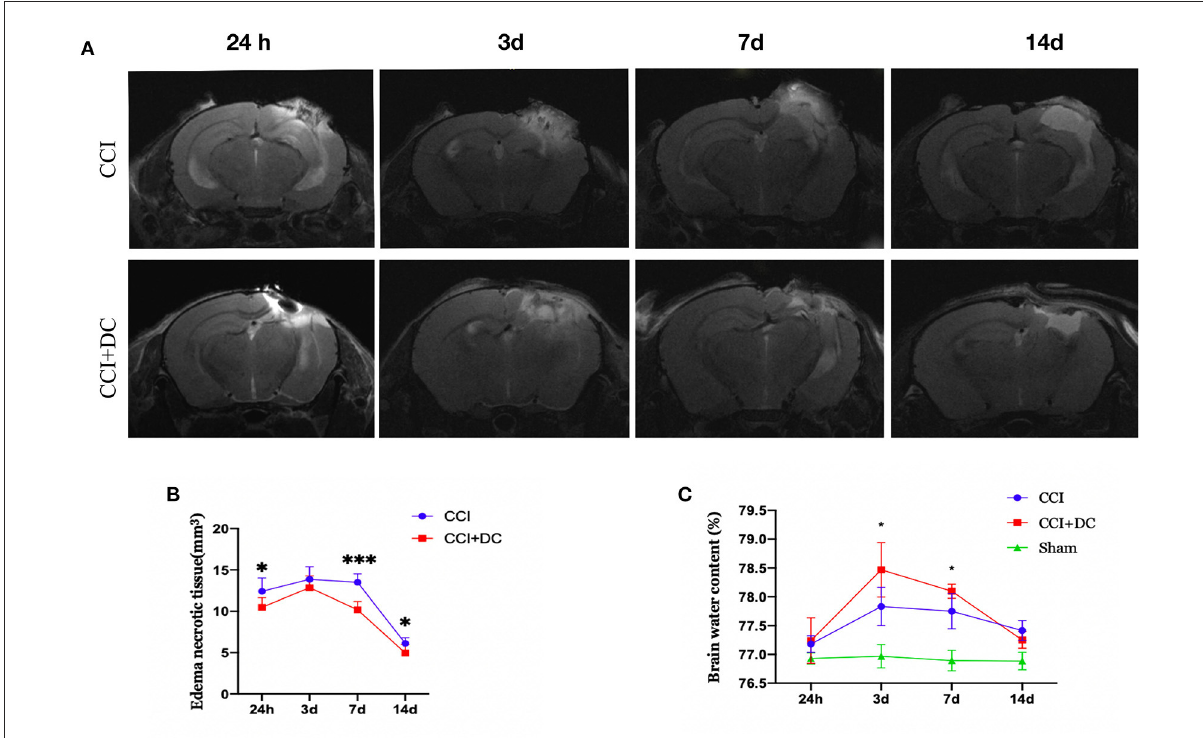
FIGURE6 Effect on cerebral edema. (A) MR examination was performed at different time points after CCI. (B) The statistical results were shown intracranial edema and contusion tissues of mice in the CCI + DC group at each time point after CCI was lower than that of the CCI group, and the difference was statistically significant on the first, 7th and 14th day after CCI. (C) Brain water content was detected by extracting brain tissue, as shown in the (C) on the 3rd and 7th day after CCI, the degree of brain edema in the CCI + DC group was significantly worse than that in the CCI group, and the difference was statistically significant ( n = 6/group, * P < 0.05, *** P < 0.001 vs. CCI